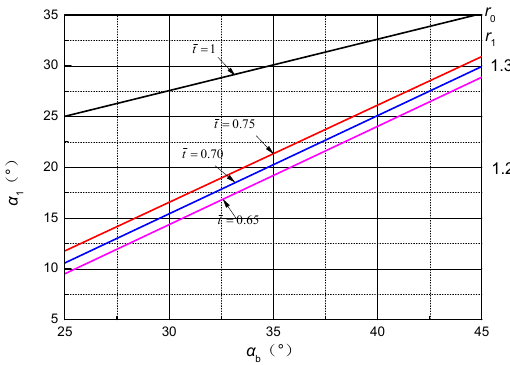
  relationship curves for TC ‐ 4P blade profile. Figure 2. Figure 2. α b − α 1 relationship curves for TC-4P blade 1 b